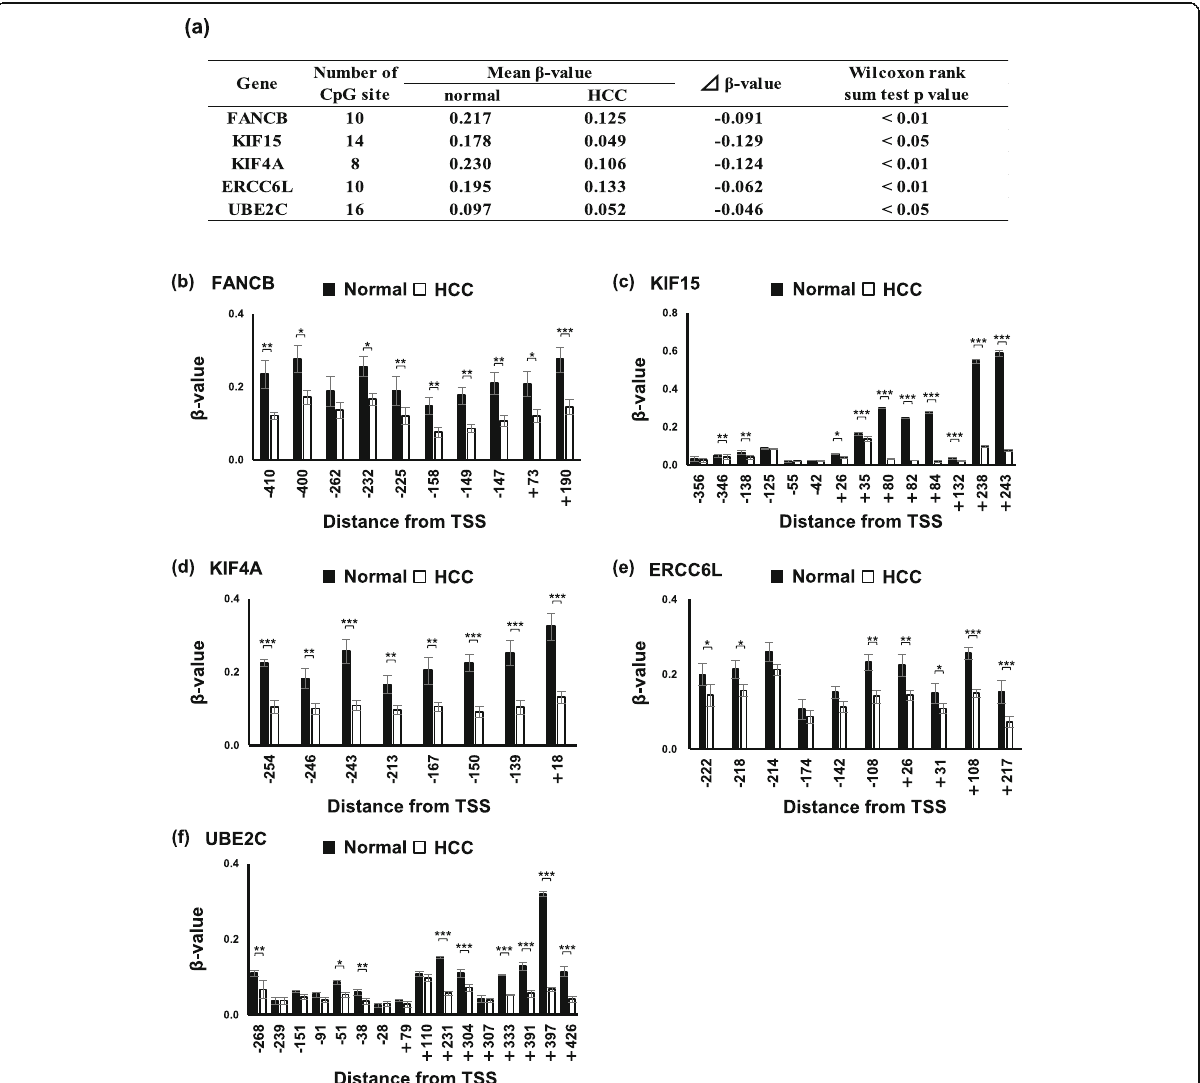
Fig. 3 CpGis of FANCB , KIF15 , KIF4A , ERCC6L , and UBE2C were hypomethylated in HCC tissues. a Mean methylation β values were calculated using data from 74 HCC tissues highly expressing each gene and data from 41 non-tumor tissues. Wilcoxon rank sum test was conducted using an online program and p value < 0.05 was considered statistically significant. The β values of CpG in CpGi of FANCB ( b ), KIF15 ( c ), KIF4A ( d ), ERCC6L ( e ), and UBE2C ( f ) in 74 HCC tissues highly expressing each gene were compared with the β values of 41 non-tumor tissues. Statistical significance between the two groups was analyzed by Student ’ s t test. *. **. *** Significantly different at p < 0.05, p < 0.01, and p < 0.001,